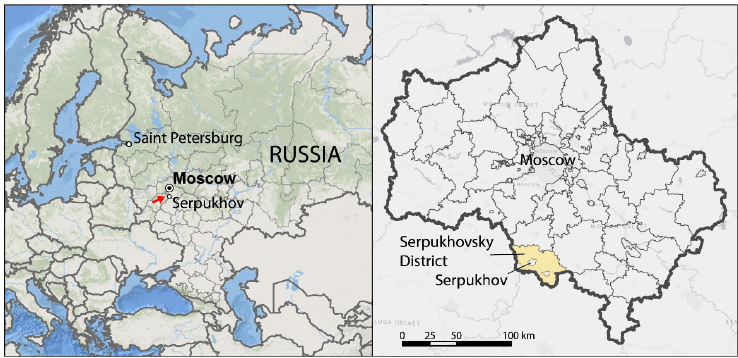
Figure 1. Location of the study